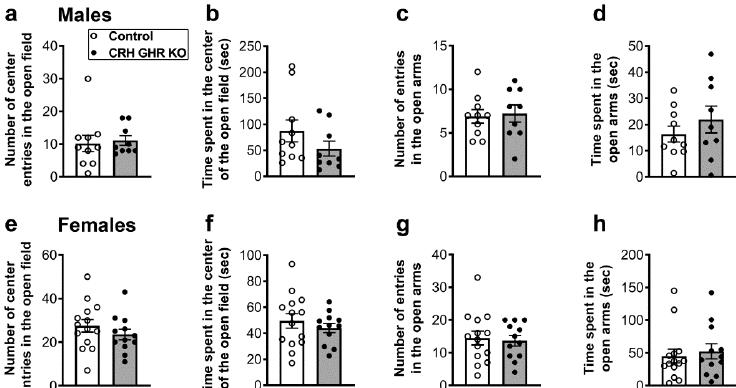
Figure 7. CRH GHR KO mice exhibit normal anxiety. ( a , b ) Number of entries ( a ) and time spent ( b ) in the center of the open field in control ( n = 10) and CRH GHR KO ( n = 9) male mice. ( c , d ) Number of entries ( c ) and time spent ( d ) in the open arms during the elevated plus maze test in control ( n = 10) and CRH GHR KO ( n = 9) male mice. ( e , f ) Number of entries ( e ) and time spent ( f ) in the center of the open field in control ( n = 14) and CRH GHR KO ( n = 12) female mice. ( g , h ) Number of entries ( g ) and time spent ( h ) in the open arms during the elevated plus maze test in control ( n = 14) and CRH GHR KO ( n = 12) female mice.